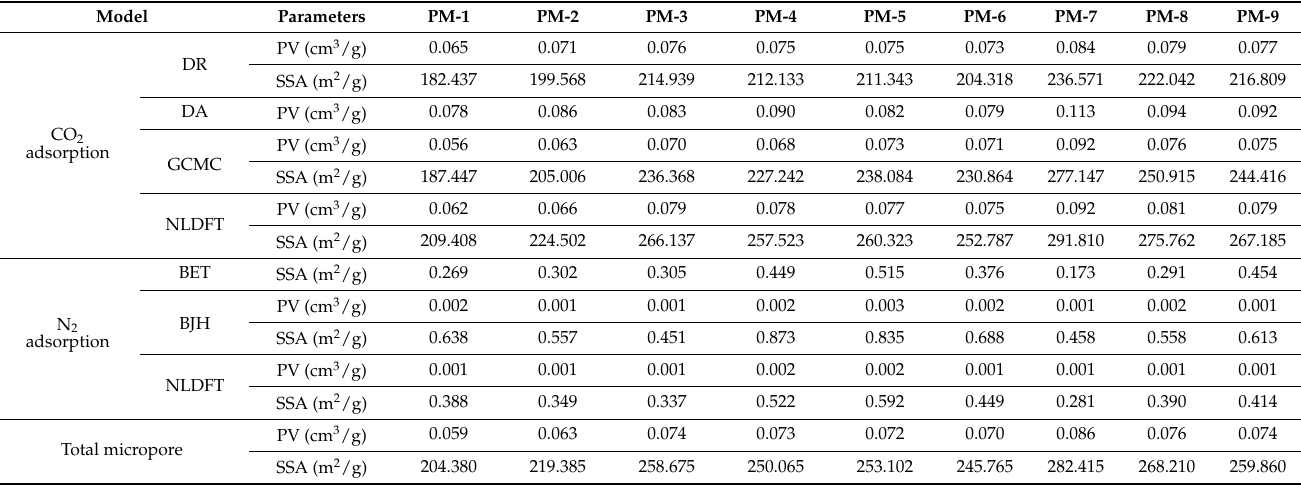
Table 2. The PV and SSA of LP-CO 2 /N 2 GA calculated by different